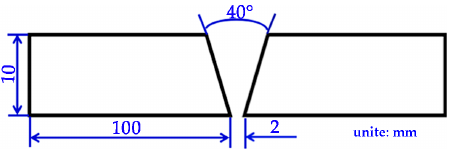
Figure 2. Schematic sketch of the weld joint.